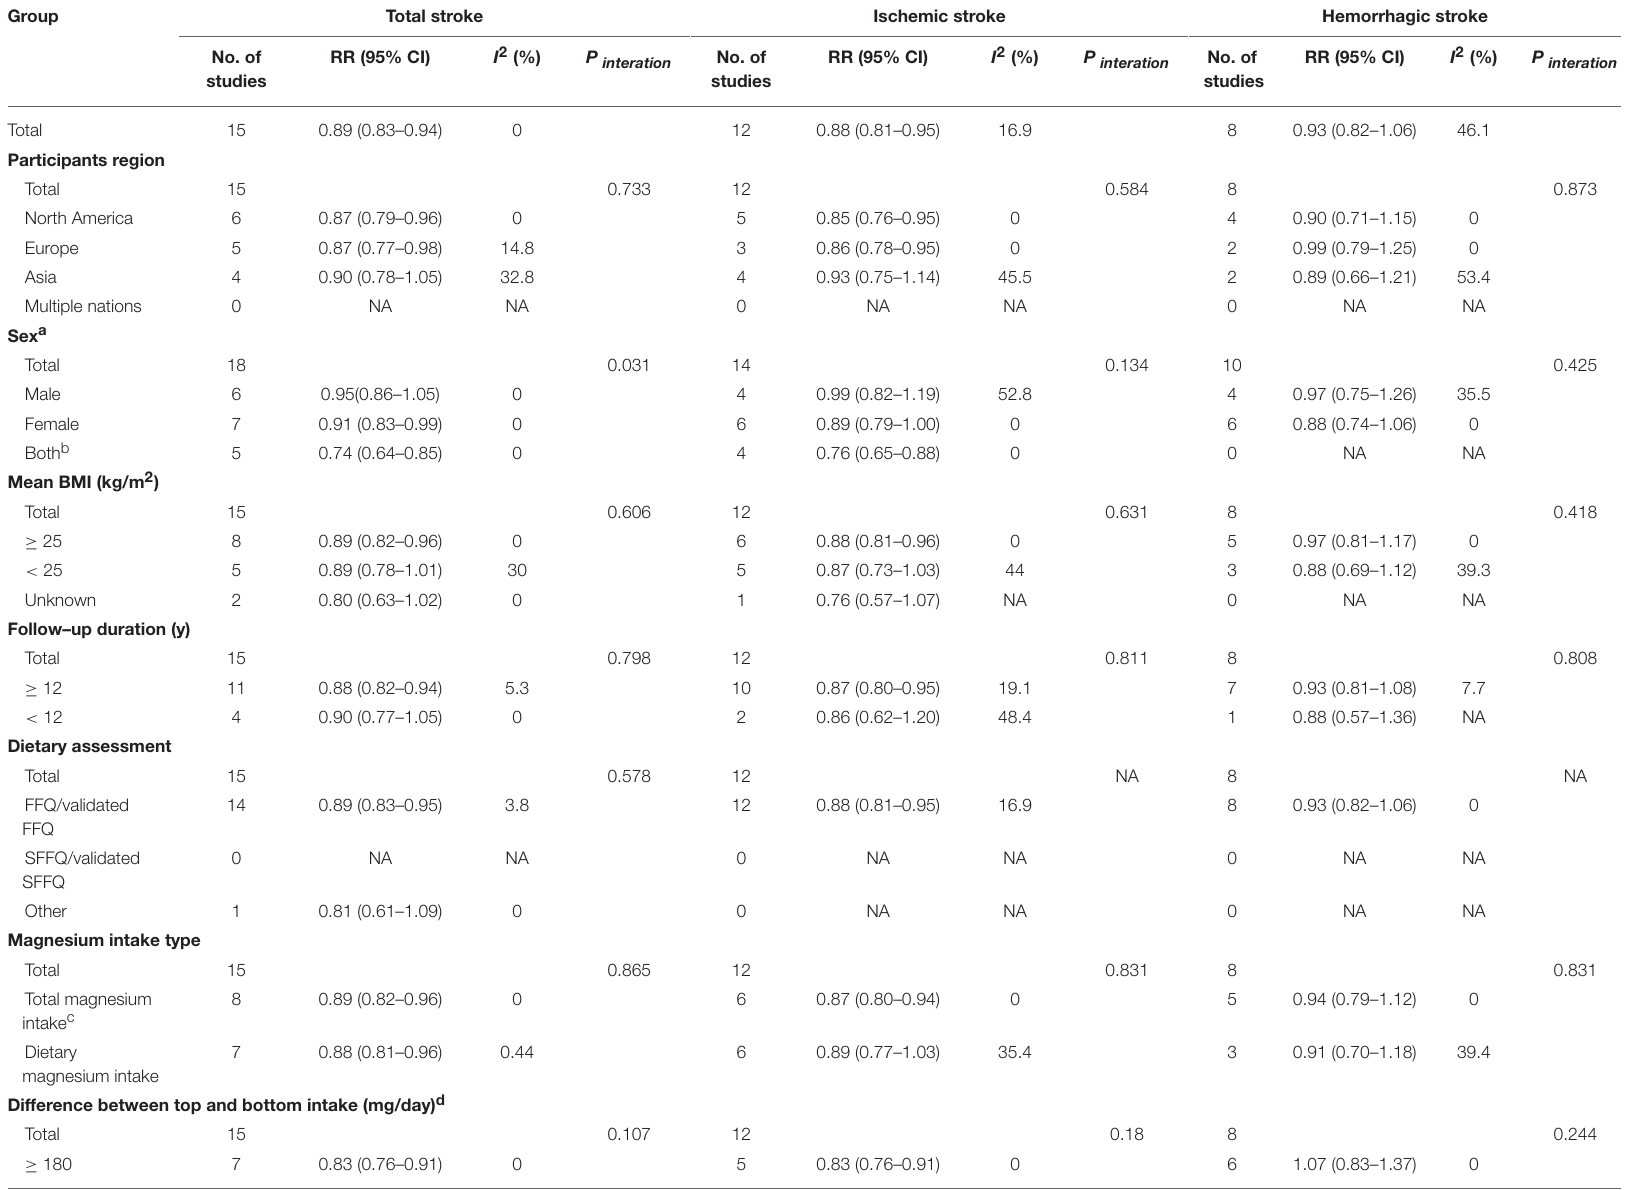
TABLE 1 | Subgroup analyses relating to magnesium intake and total stroke, ischemic stroke, hemorrhagic